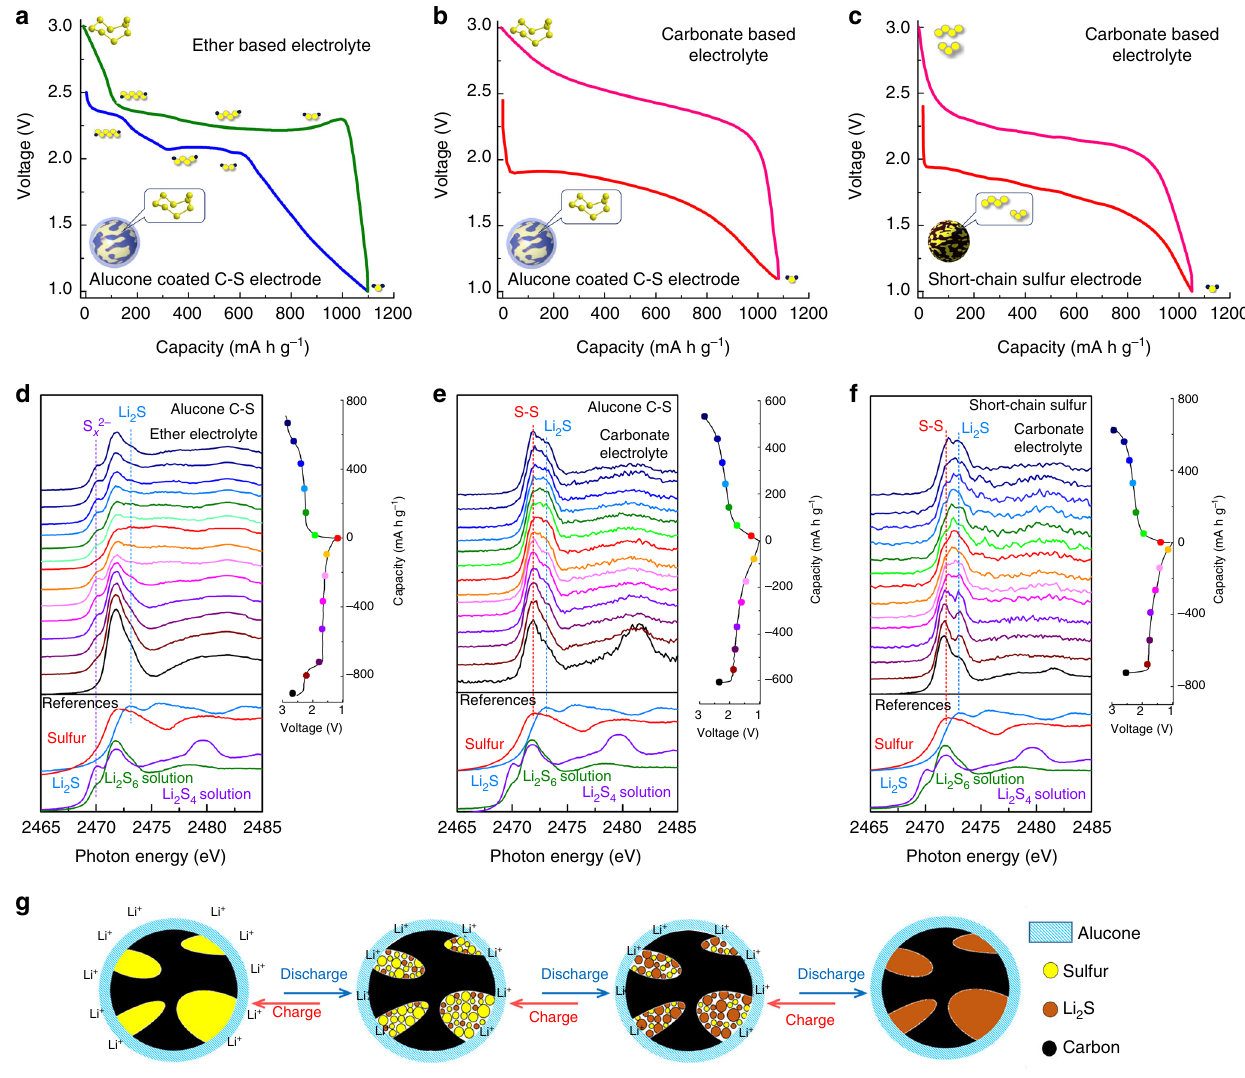
Fig. 2 Understanding the reaction mechanisms of different lithium – sulfur cells. a – c Discharge – charge pro fi les of different types of lithium – sulfur cells. In operando X-ray absorption near-edge spectroscopy study of d alucone-coated C – S electrode in ether-based electrolyte, e alucone-coated C – S electrode in carbonate-based electrolyte, and f as-prepared short-chain sulfur electrode in carbonate-based electrolyte. g Schematics for proposed mechanism of alucone C – S cathodes in carbonate-based